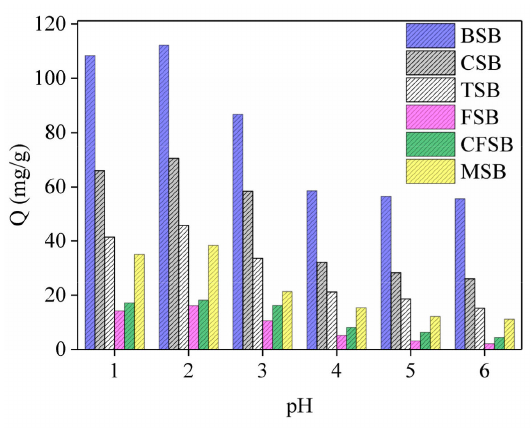
Figure 5. E ff ect of adsorption on Cr(VI) at di ff erent pH